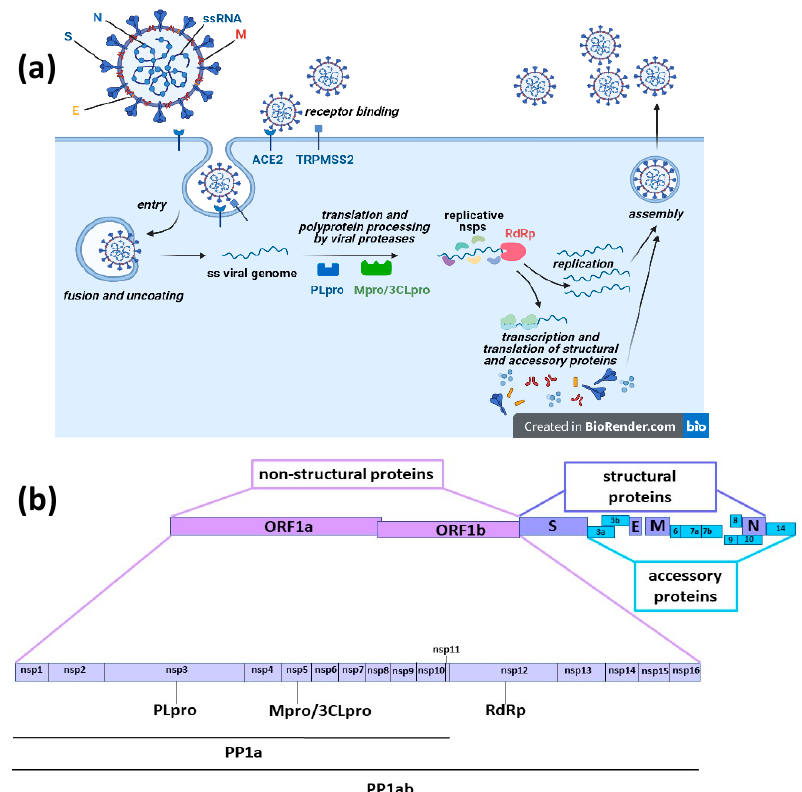
Figure 1. ( a ) SARS-CoV-2 is an enveloped positive-sense single-stranded RNA virus. In mature virions, structural proteins surround and interact with the viral genome (spike (S), envelope (E), membrane (M) and nucleocapsid (N) proteins). Virions enter target cells after specific binding of the receptor-binding domain (RBD) of the viral protein S to the cellular entry receptor, the angiotensin- converting enzyme 2 (ACE2). Viral uptake is promoted by the proteolytic activity of host factors, like the cell-surface transmembrane serine protease 2 (TMPRSS2), whose enzymatic activity is essential to permit the fusion with the cellular membrane and virus entry. Once entered target cells, virions are uncoated and viral RNA is released in the cytosol and immediately translated into two large polyproteins, pp1a and pp1ab, specified by two large open reading frames of the viral RNA, ORF1a and ORF1b. Both polyproteins contain the amino acid sequences of viral non-structural proteins (nsps). pp1a contains nsp1 to nsp11, while pp1ab contains nsp1 to nsp10 and nsp12 to nsp16. These polyproteins are co-translationally and post-translationally processed through proteolytic cleavage by two viral cysteine proteases residing in the nsp3 and nsp5 sequence, the papain-like protease (PLpro) and the main protease or 3C-like protease (Mpro/3CLpro), respectively. Released nsp1 inhibits host mRNA translation, while nsp2 to nsp16 are involved in the intracellular viral replication cycle; in particular, nsp12 is the RNA dependent RNA polymerase (RdRp) that with the cofactors nsp7 and nsp8 performs viral RNA synthesis for translation and synthesis of structural and accessory